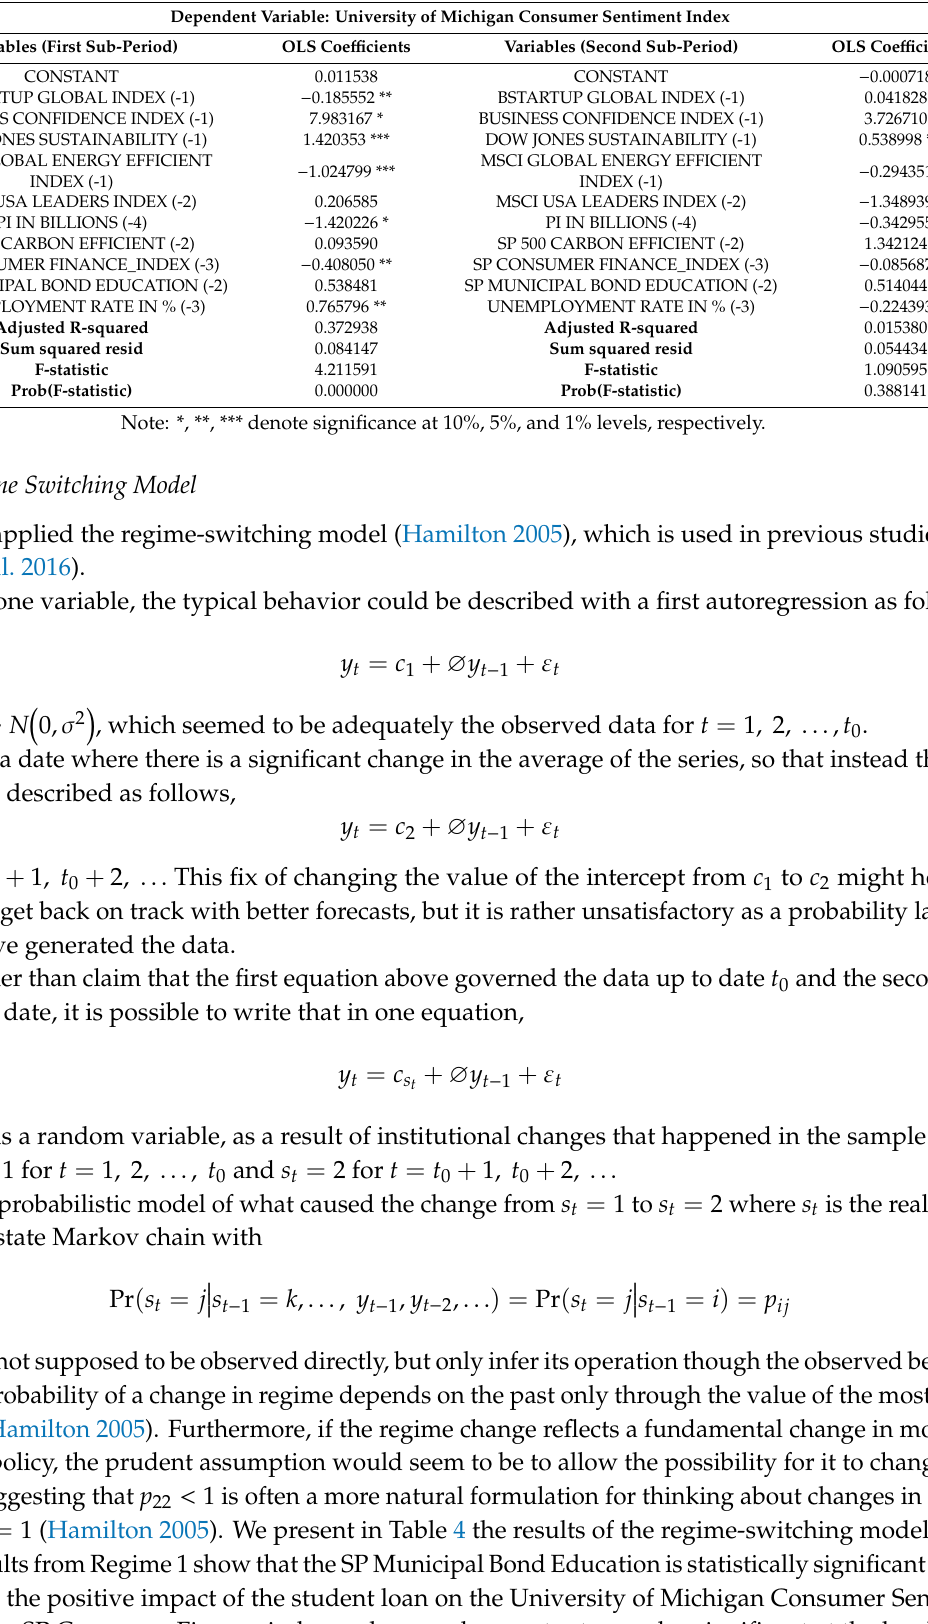
Table 3. Results of regression